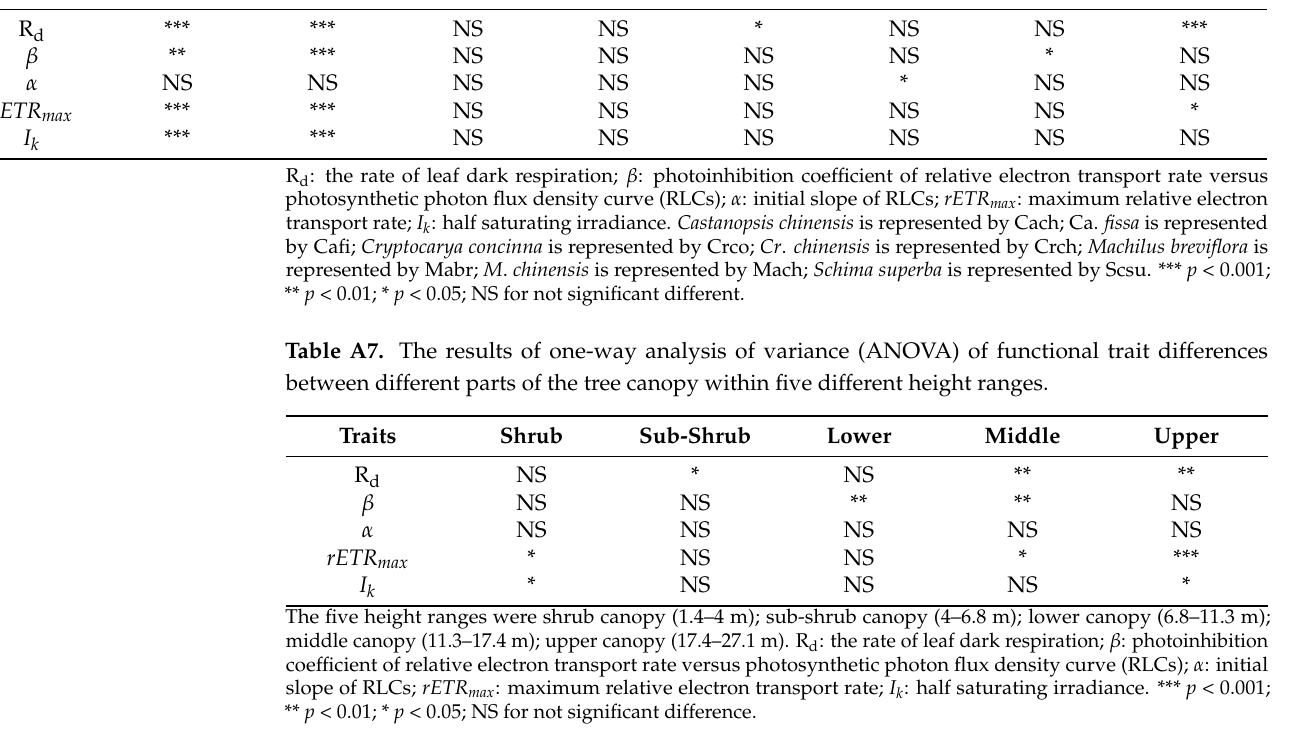
Table A8. The results of one-way analysis of variance (ANOVA) of intra-specific variability of functional traits among different crown part of each